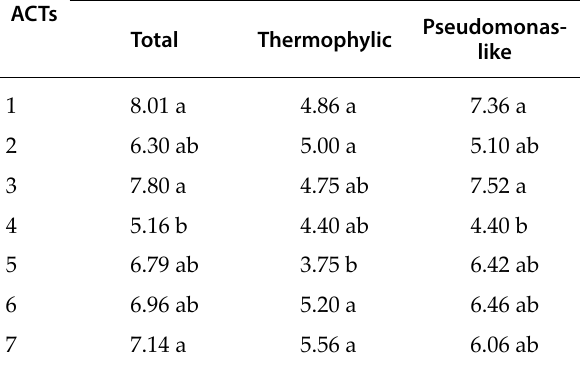
Table 1. Culturable bacterial populations resident in seven different aerated compost teas (ACTs). Different letters within a column indicate significant differences ( P ≤0.05) according to Duncan’s test.